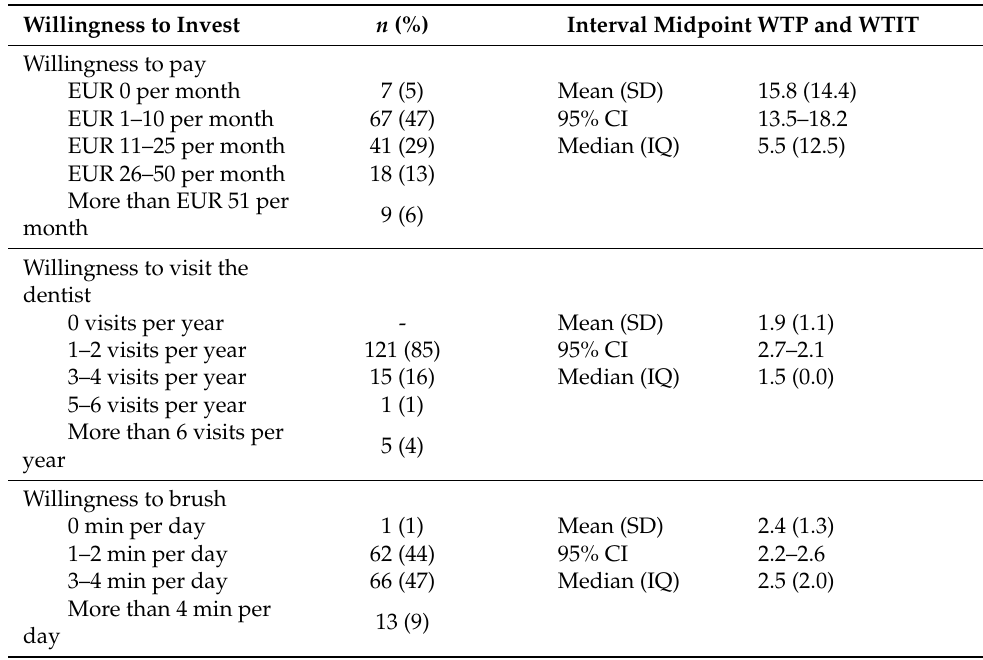
Table 3. Willingness to invest in child’s oral